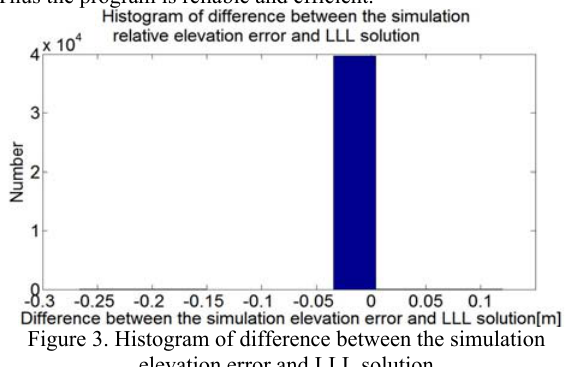
Figure 3. Histogram of difference between the simulation elevation error and LLL solution